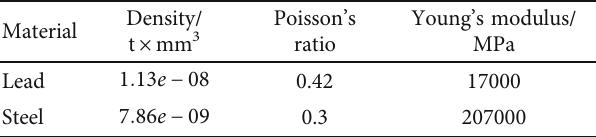
Table 4: Basic data for lead and steel.